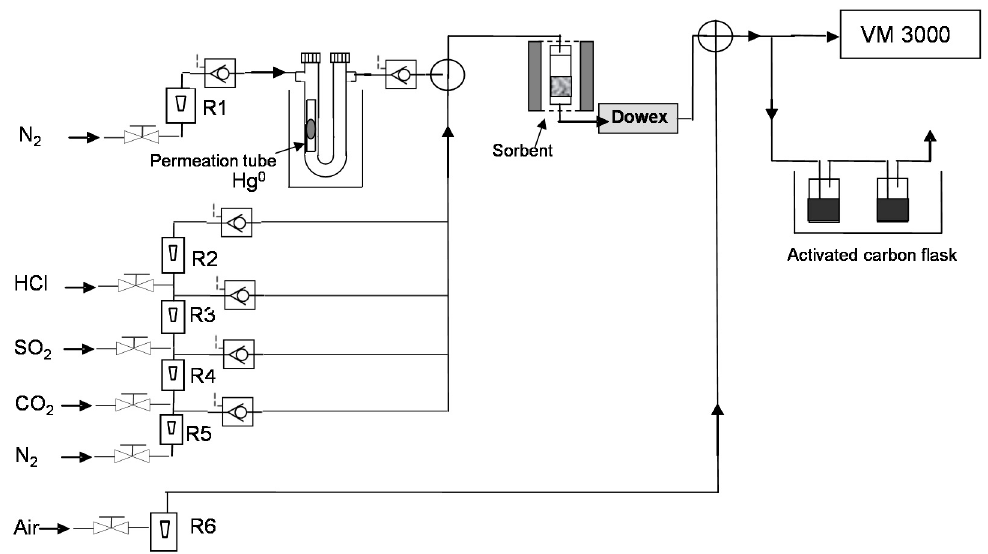
Figure 1. Schematic diagram of the experimental device used for mercury retention.